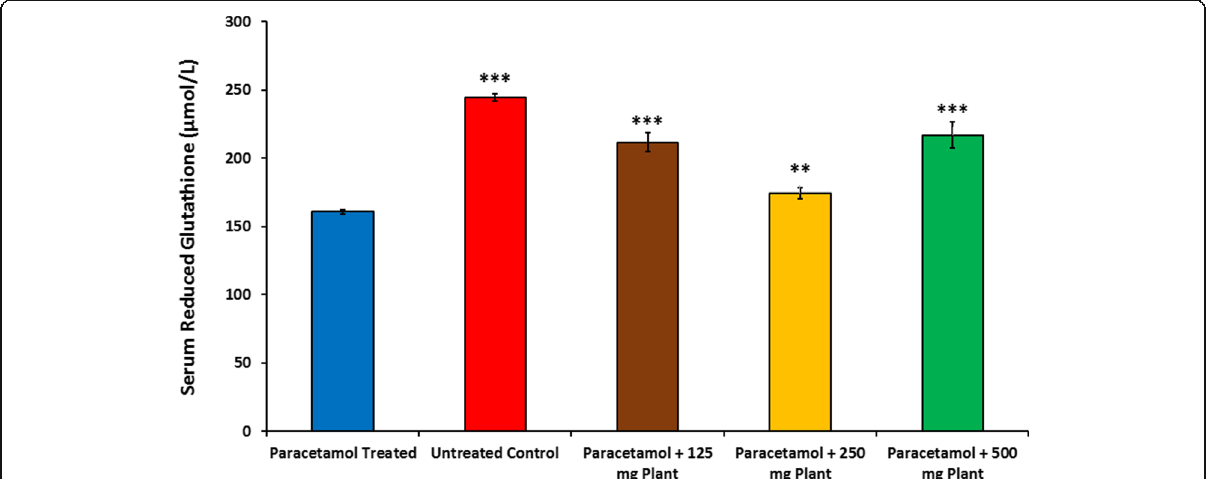
Fig. 5 Bar charts showing the effect of A. orientalis on antioxidant enzyme, serum reduced glutathione (GSH) in paracetamol treated, untreated control, paracetamol A. orientalis pretreated 125, 250, 500 mg/kg BW mice groups. Note that in all doses GSH levels were significantly increased compared to paracetamol treated mice group. Data are presented as: mean ± SEM, n = 6, ** or *** P < 0.05 showed moderate or sever significant difference, respectively